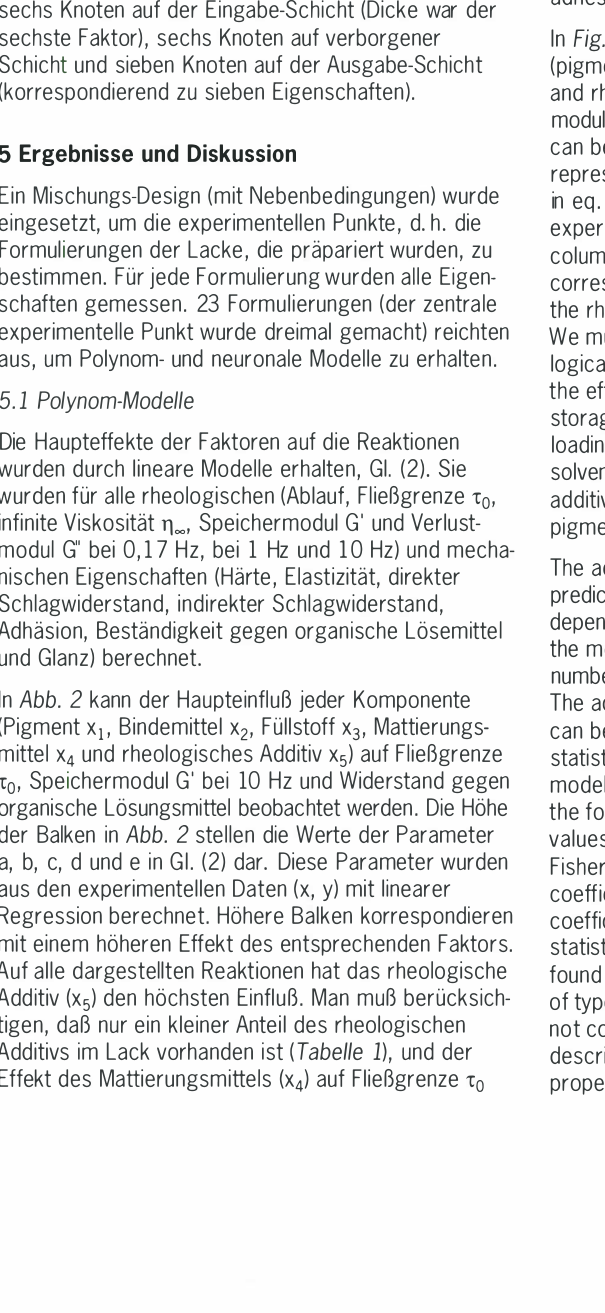
Tabelle 1: Daten, die zur Modellierung der Flieagrenze (To) mit Polynomen benutzt wurden. In den Spalten